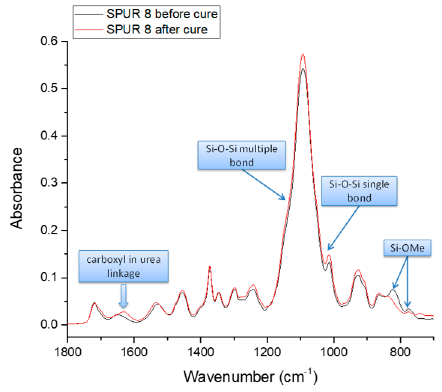
Figure 6. The comparison of ATR-FTIR spectra of SPUR 8 before and after cure.